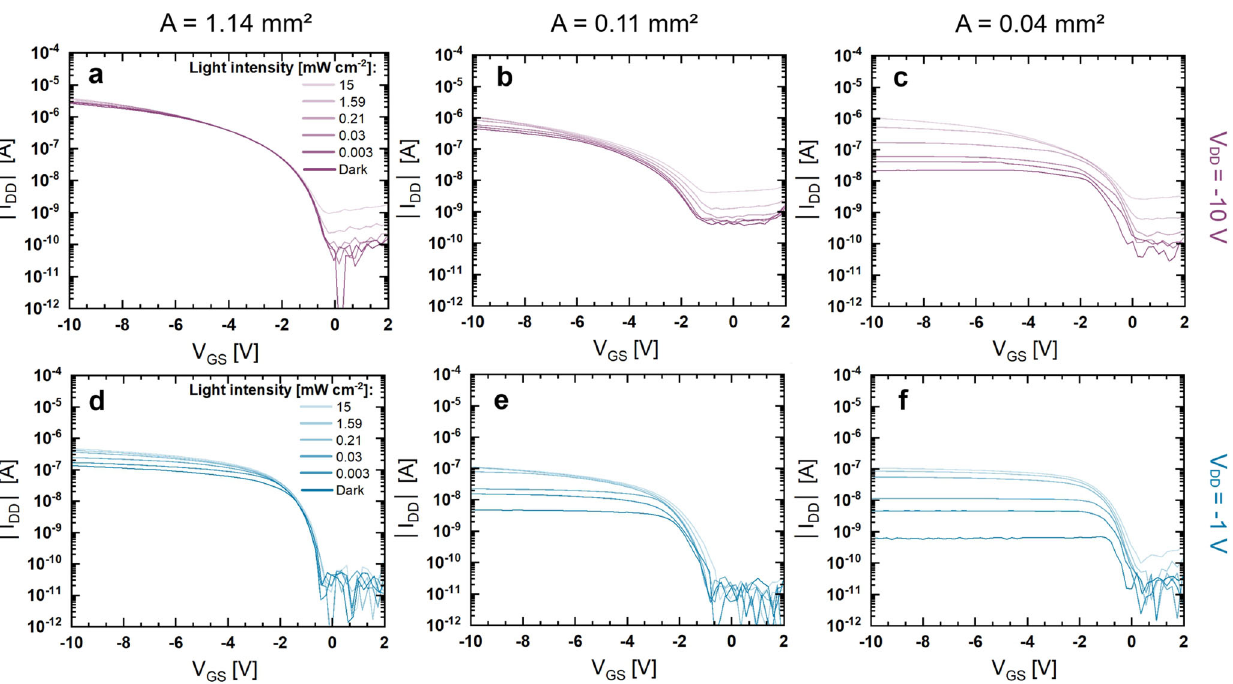
Fig. 3 Characteristics of integrated devices. a – c Transfer characteristics of the integrated devices in the saturation regime (V DD = − 10 V). The different integrated devices have an OPD size of 1.14, 0.11, and 0.04 mm 2 , respectively. d – f Transfer characteristics of the integrated devices in the linear regime (V DD = − 1 V). The different integrated devices have an OPD size of 1.14, 0.11, and 0.04 mm 2 ,